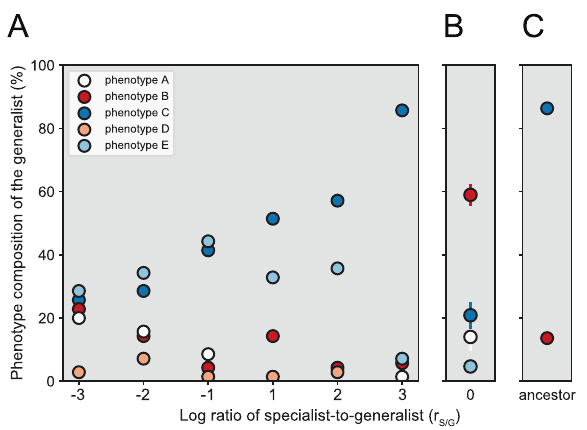
Fig. 6 Phenotype composition of the generalist population after 12 serial batch transfers at pH 6.5 (strong nitrite toxicity). After 12 serial transfers, we isolated individual generalists from one experimental series and assigned each isolate to a phenotype group